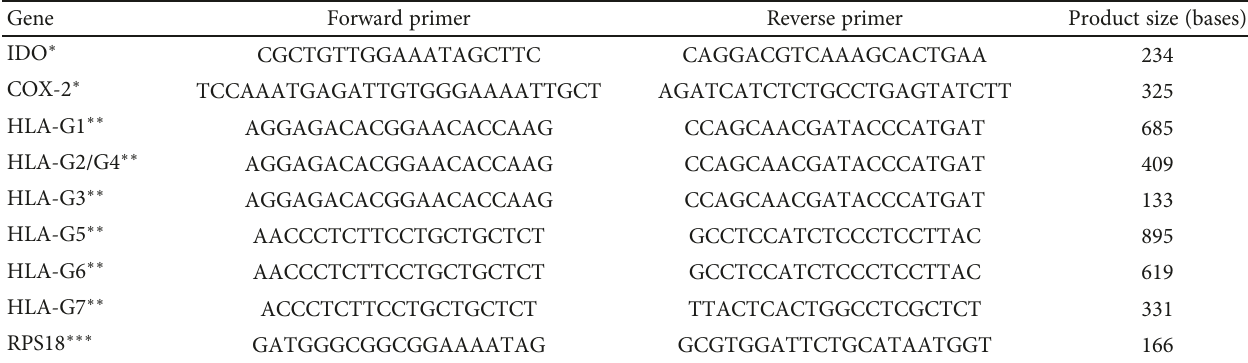
Table 1: List of primers used in this experiment.